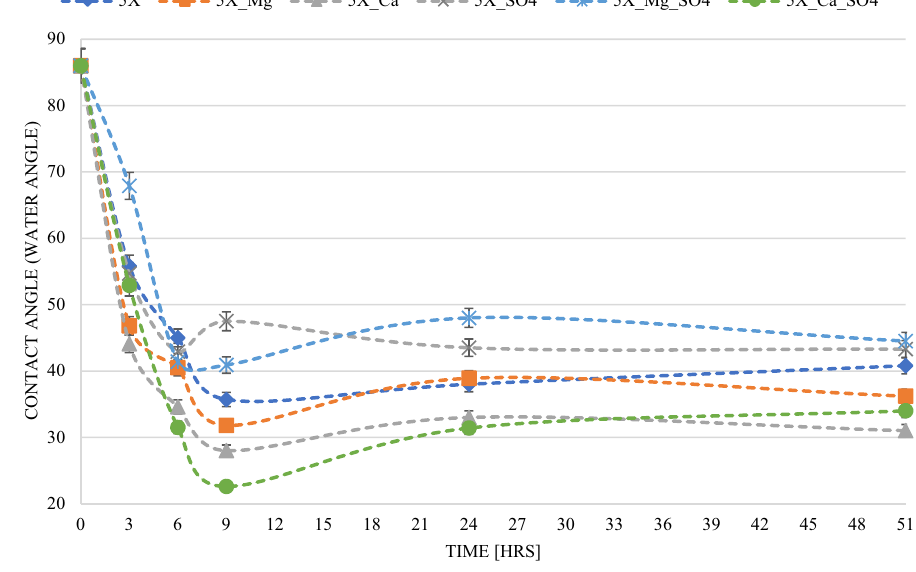
Fig. 4 Effect of PDIs on the rate of CA